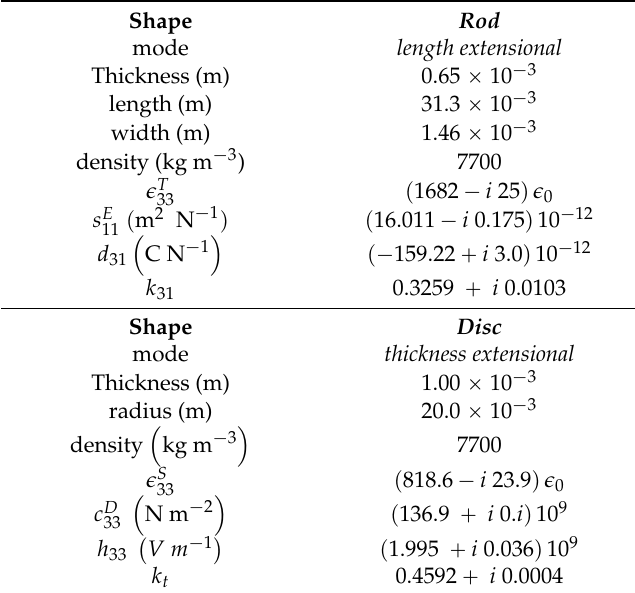
Table 1. Experimental characterization parameters obtained by Alemany’s method for two samples of PZ27 piezoceramic. Shape Rod